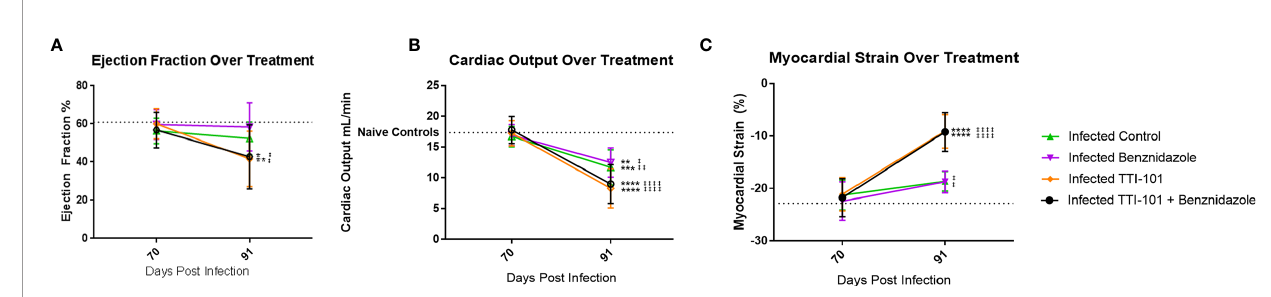
FIGURE 8 | Cardiac function measured on echocardiography. Echocardiography was performed pre- and post-treatment to evaluate changes to cardiac function. All infected groups are compared to the naive untreated and naive TTI-101-treated groups (no signi fi cant differences were seen between the naive untreated and naive TTI-101-treated groups). Summary data measurements of ejection fraction (A) and cardiac output (B) measured by M mode echocardiography before and after treatment compared to naive control averages (dotted line). Summary data levels of myocardial strain of the left ventricle measured by B mode echocardiography before and after treatment compared to naive control average (dotted line; (C ). Short-axis images were used to determine myocardial circumferential strain (C) . Representative images from one of two replicate experiments are shown. Error bars represent SD. Data were analyzed with Student ’ s t-test. When comparing groups to naive control, *p < 0.05, **p < 0.01, ***p < 0.001, ****p < 0.0001. For each group when comparing pre-treatment to post-treatment values ± p < 0.05, ±± p < 0.01, ±±±± p <